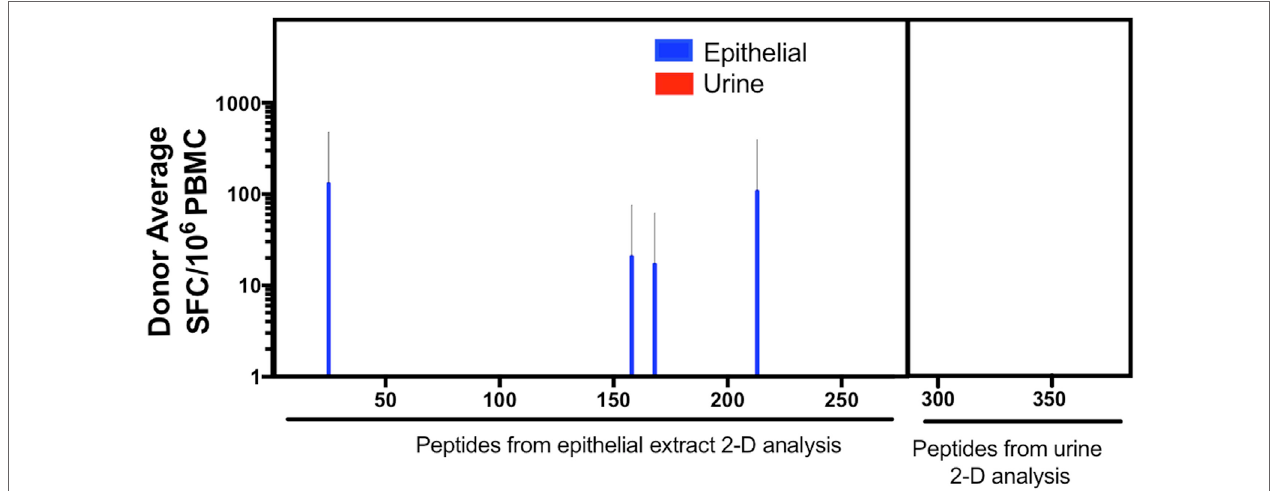
FigUre 4 | T cell responses against previously undescribed IgG and IgE-reactive mouse proteins. Cytokine production (IL-5 + IFN γ ) was measured as spot forming cells (SFC), by ELISPOT in response to predicted peptides derived from immunoproteomic analysis of mouse urine and epithelium. Error bars indicate